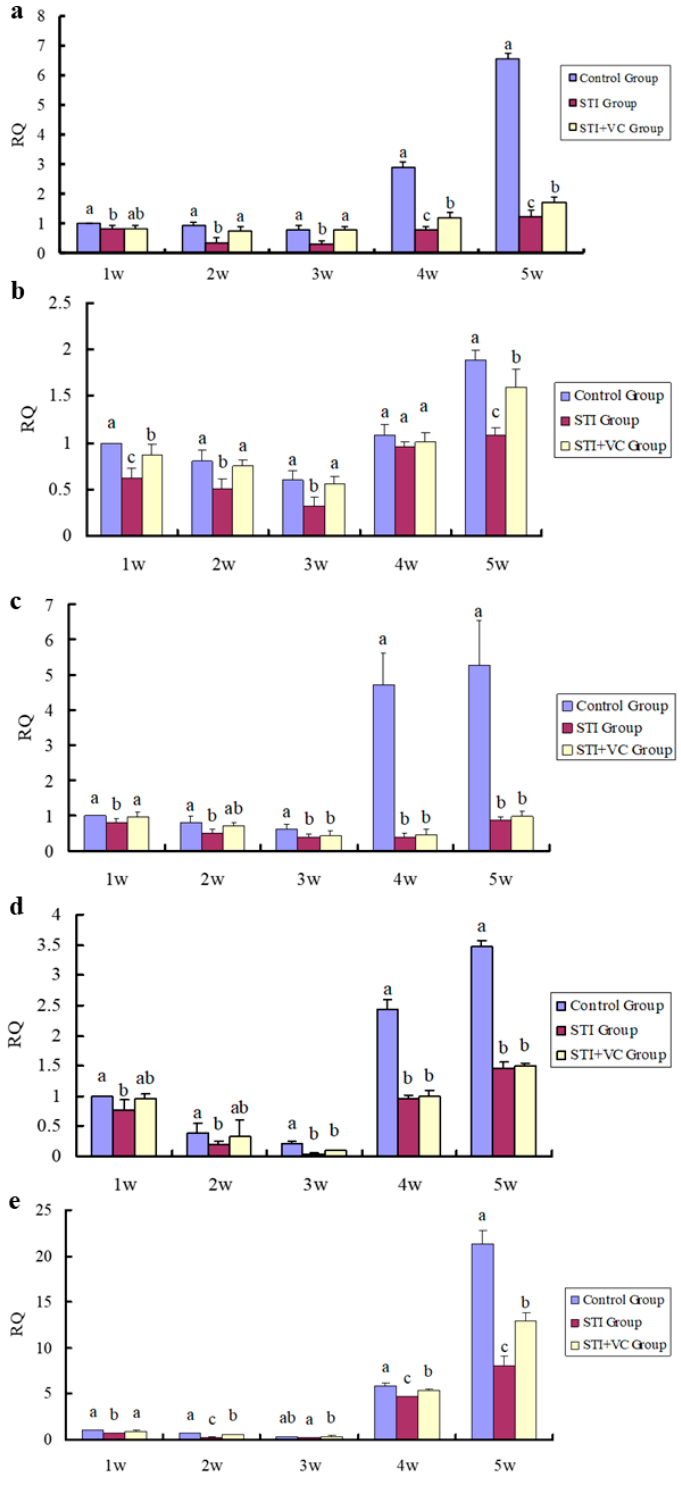
Figure 1. RT-PCR gene expression analysis of relative gene expression. ( a ) SOD; ( b ) GSH-Px; ( c ) TPS; ( d ) SST; ( e ) SSTR5; Different letters indicate significant differences between the groups ( p < 0.05, n = 10).